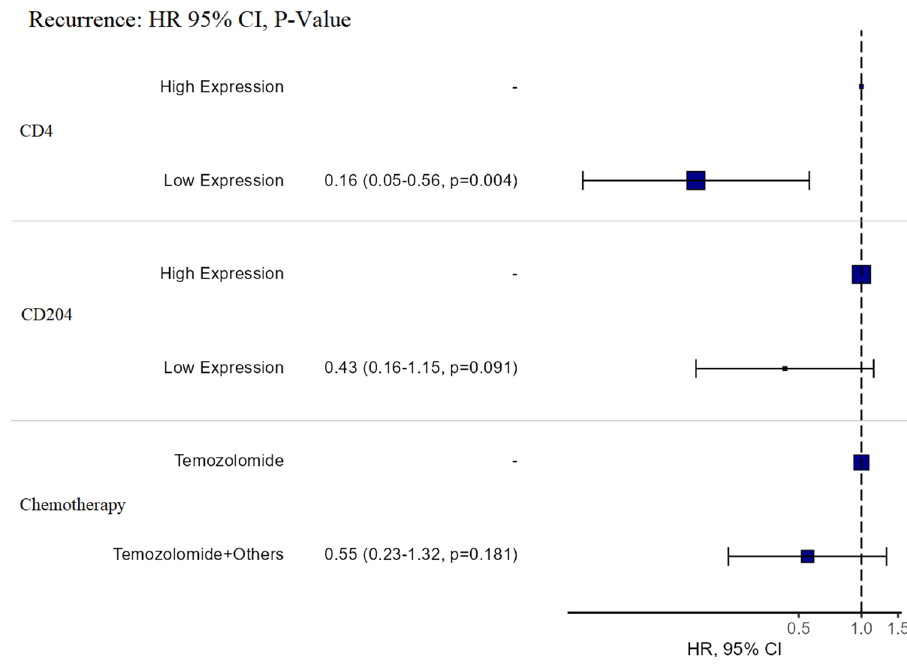
Fig. 7 Relationship between CD204 + TAMs and CD4 + TILs with the RFI in glioblastoma patients who received specific types of chemotherapy using the multivariate HR. There was a lower chance of tumour recurrence in cases with a low expression of CD204 + TAMs. There was a lower chance of tumour recurrence after treat- ment with TMZ and